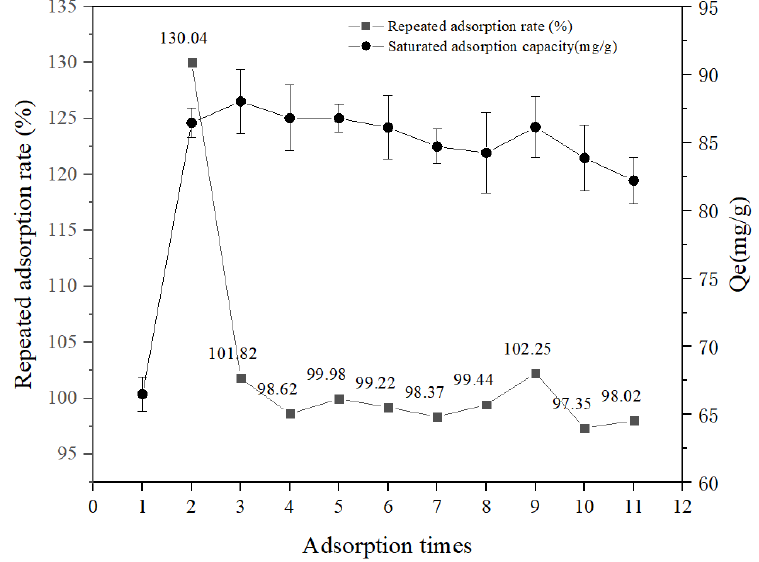
Figure 8. Reusability tests of SFP/SA-80 hydrogel microsphere for CV